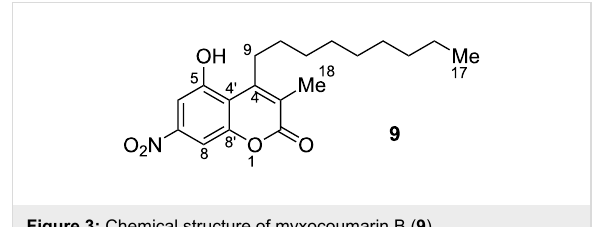
Figure 3: Chemical structure of myxocoumarin B ( 9